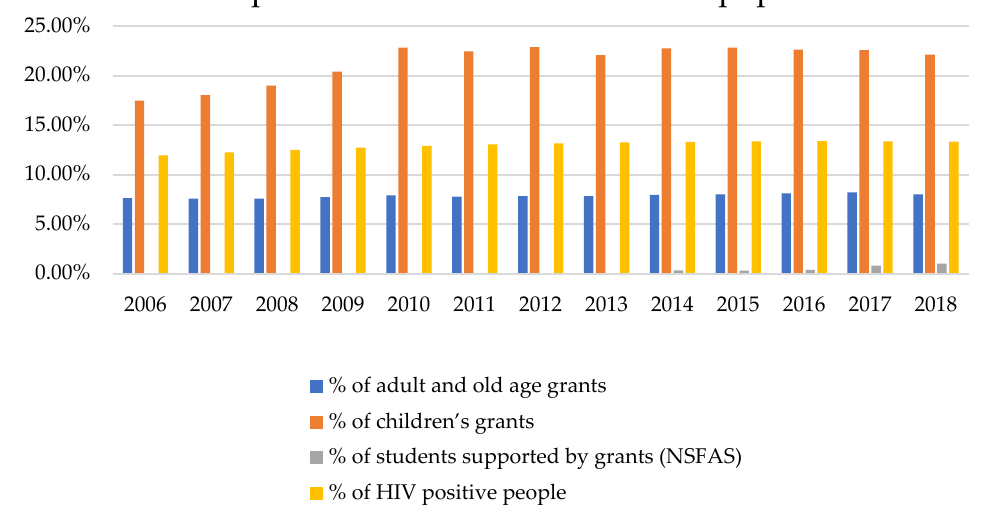
Figure 1. Dependence on the state in South Africa (Source: Own construction using Quantec (2020)).